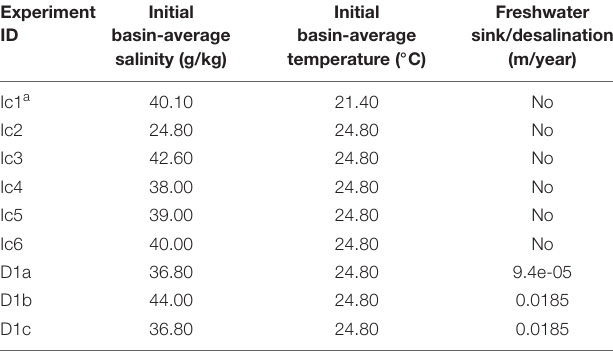
TABLE 1 | Overview of simulation experiments: in the first set of 10-year-long experiments GARM is initialized with different Gulf basin-average salinities (Ic1–Ic6); and in the second set of 19-year-long experiments GARM is initialized with a low (D1a and D1c); and a high (D1b) initial Gulf basin-average salinity and continuous seawater desalination perturbation is included for the duration of the